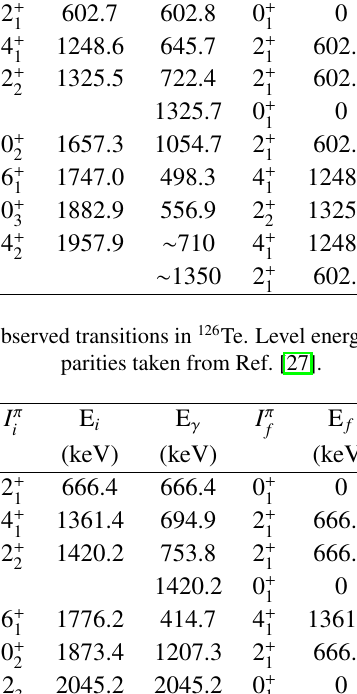
Figure 2. Spectra for the region from 900 to 1200 keV in Run F as defined in Table 1 (enriched 130 Te target). The top and bottom panels display data from 65 ◦ and 115 ◦ detectors, Table 4. Observed transitions in 128 Te. Level energies, spins and parities taken from Ref. [28].